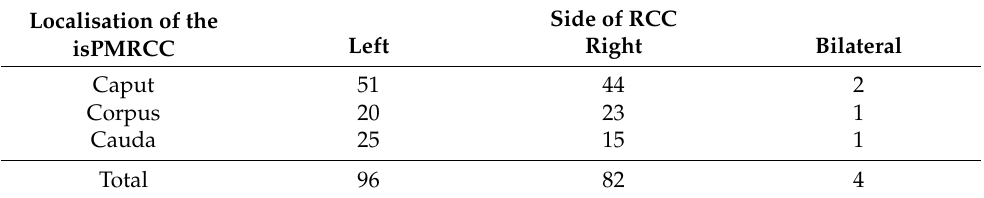
Table 1. Side of the primary renal cell carcinoma (RCC) and the location of metastases within the pancreas ( n = 182; p = 0.707); (isPMRCC = isolated pancreatic metastases of renal cell carcinoma.) Side of RCC Localisation of the Left Right Bilateral isPMRCC Caput 51 44 2 Corpus 20 23 1 Cauda 25 15 1 Total 96 82 4 The impact of the systemic MP is further underlined by the fact that of the